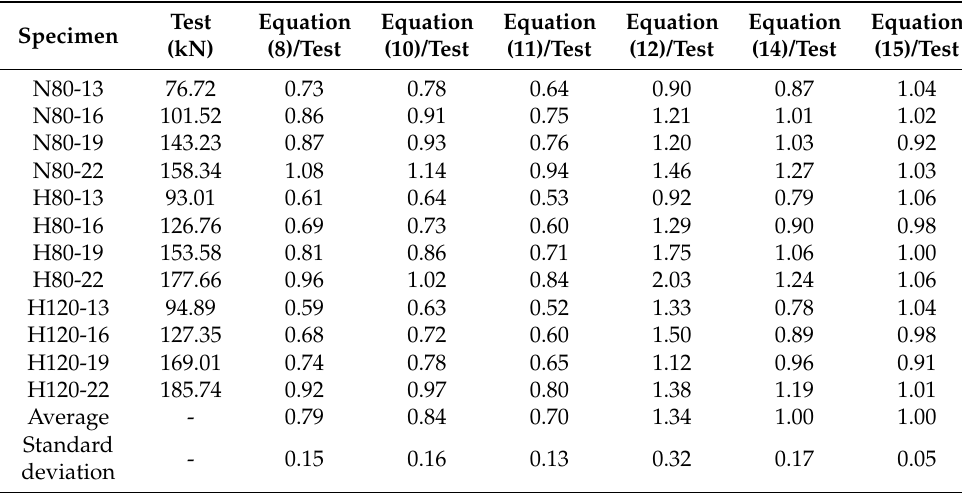
Table 7. Comparisons of test and calculation results of stud shear